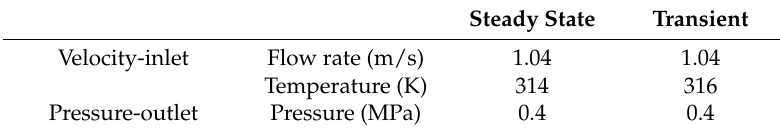
Figure 6. The measured temperature and velocity at HS. Table 2. The input parameters of the CFD model boundary conditions.